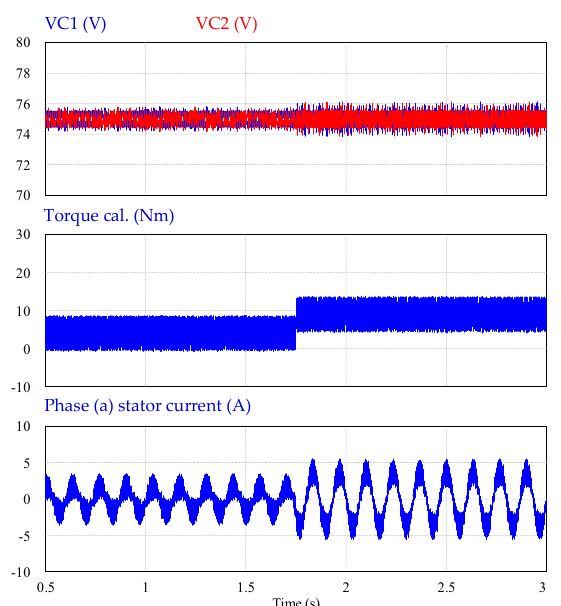
Figure 12. Simulation result of the transient-state operation of the conventional four-level HTC under neutral-point balancing at 150 r/min.